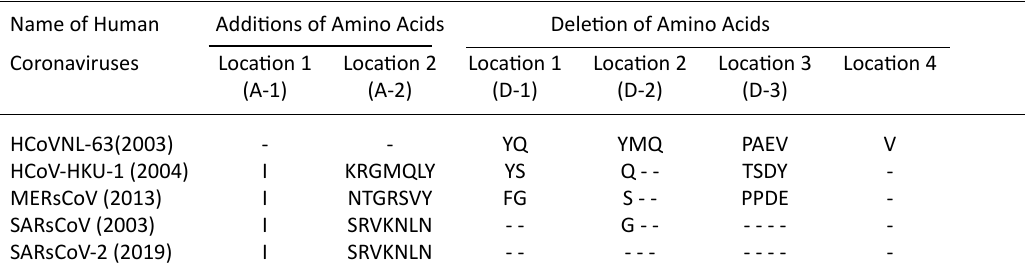
table 1. Addition and Deletion Pattern of Amino Acids in Envelope Proteins’ of Human Coronaviruses Name of Human